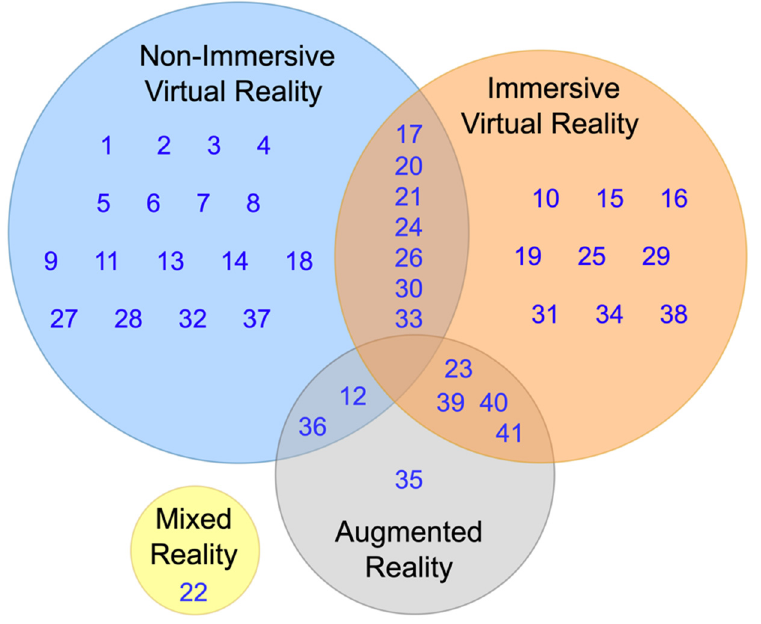
Figure 4. RVTs employed by the described applications. Numbers 1 to 41 identify the works listed in Table 4 (column “Work Number”). Table 4 (column “Work